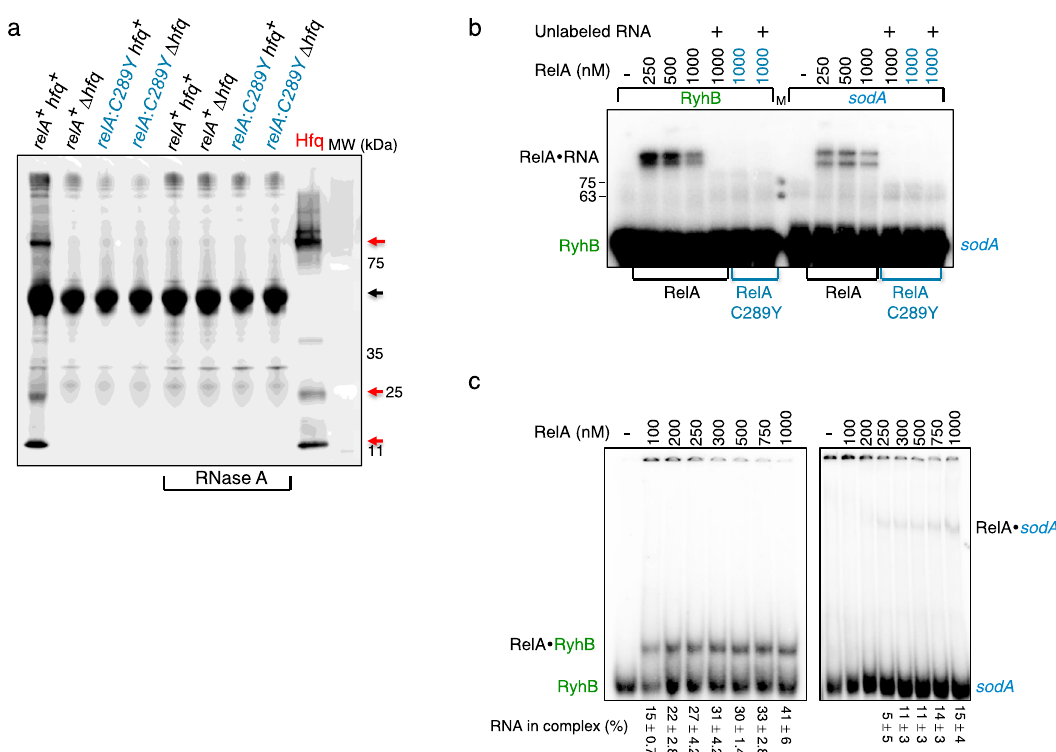
Fig. 2 RelA binds RNA. a Co-immunoprecipitation carried out with α RelA antibody and cell lysates of wild type RelA (black) and RelA:C289Y mutant (blue). The lysates were treated with RNase A (100 μ g/ml) or left untreated as indicated. Hfq was detected by western using α Hfq antibody. Puri fi ed Hfq (100 nM) was used as control. Red arrows indicate different forms of Hfq, while black arrow indicates the heavy chain of α RelA antibody. BLUeye Prestained Protein ladder (MW). b In vitro binding of RyhB and sodA by RelA. Wild type RelA (black) or RelA:C289Y (blue) incubated with labeled RNAs (1 nM; RyhB 90 nt; sodA 98 nt) were UV crosslinked. Competitor unlabeled RNA (100 nM) was added to the reaction mixtures as indicated. The binding products were analyzed by 15% SDS-PAGE. The estimated MW of the RNA • RelA complex is 107 – 113 kDa. BLUeye Prestained Protein ladder (MW). c Gel mobility shift assay of (1 nM) radiolabeled sodA (56 nt) or RyhB (50 nt) RNAs incubated with increasing concentrations of RelA as indicated. Incubations were carried out at 22 °C for 10 min. The products were UV crosslinked before loading on 4% native gel electrophoresis. RNA in complex (%) was calculated from four different experiments for each RNA. Source data provided as a source data fi